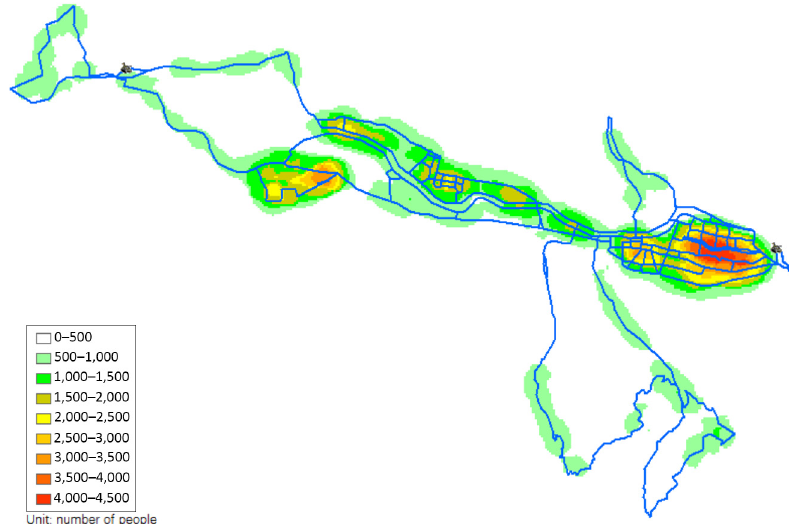
Figure 4 Spatial distribution map of sensitive target population in each section of